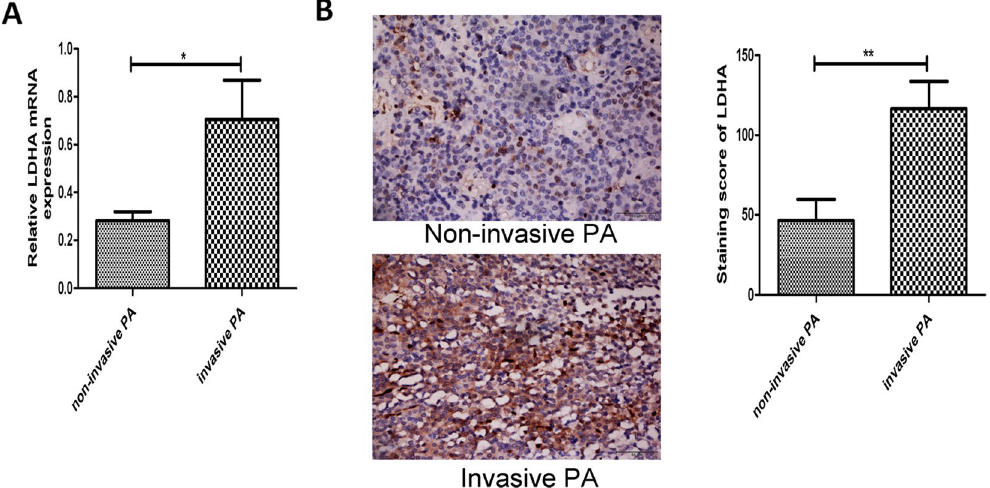
Figure 1. Expression of LDHA in human PA samples. ( A ) The expression of LDHA mRNA in human PA tissures were detected by qRT-PCR. ( B ) The expression of LDHA protein in human PA samples were examined by IHC staining. Original magnification, × 400. * P < 0.05; ** P < 0.01.